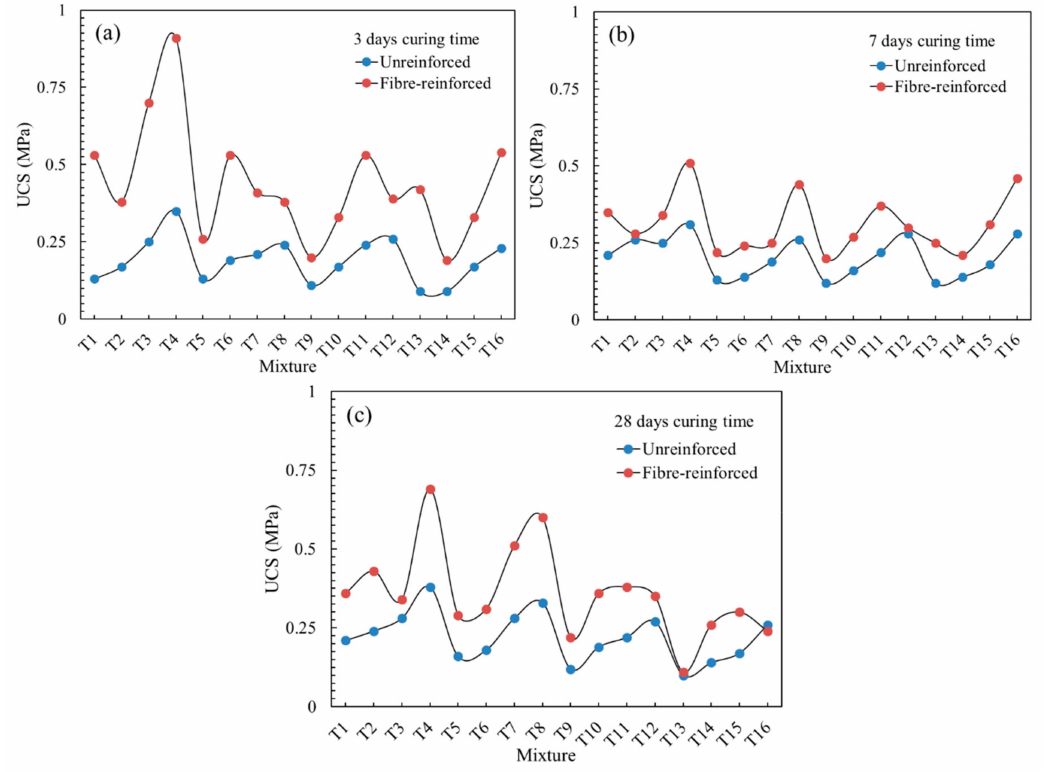
Figure 3. UCSs of the fiber-reinforced and unreinforced specimens with di ff erent curing times: ( a ) 3 days curing time; ( b ) 7 days curing time; ( c ) 28 days curing